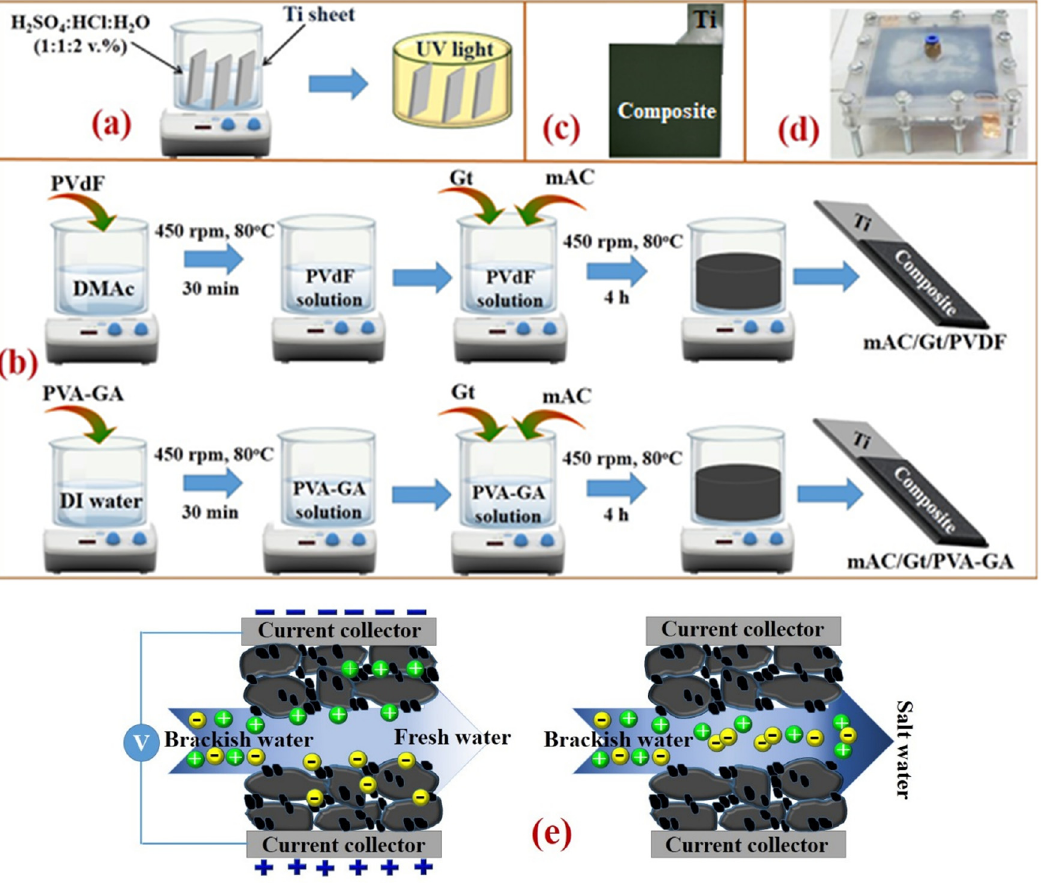
Figure A1: ( a ) Schematic of Ti substrate etching, ( b ) fabrication of mAC/Gt/PVdF, mAC/Gt/PVA - GA, ( c ) composite electrode, ( d ) stack MCDI, and ( e ) working principle of CDI